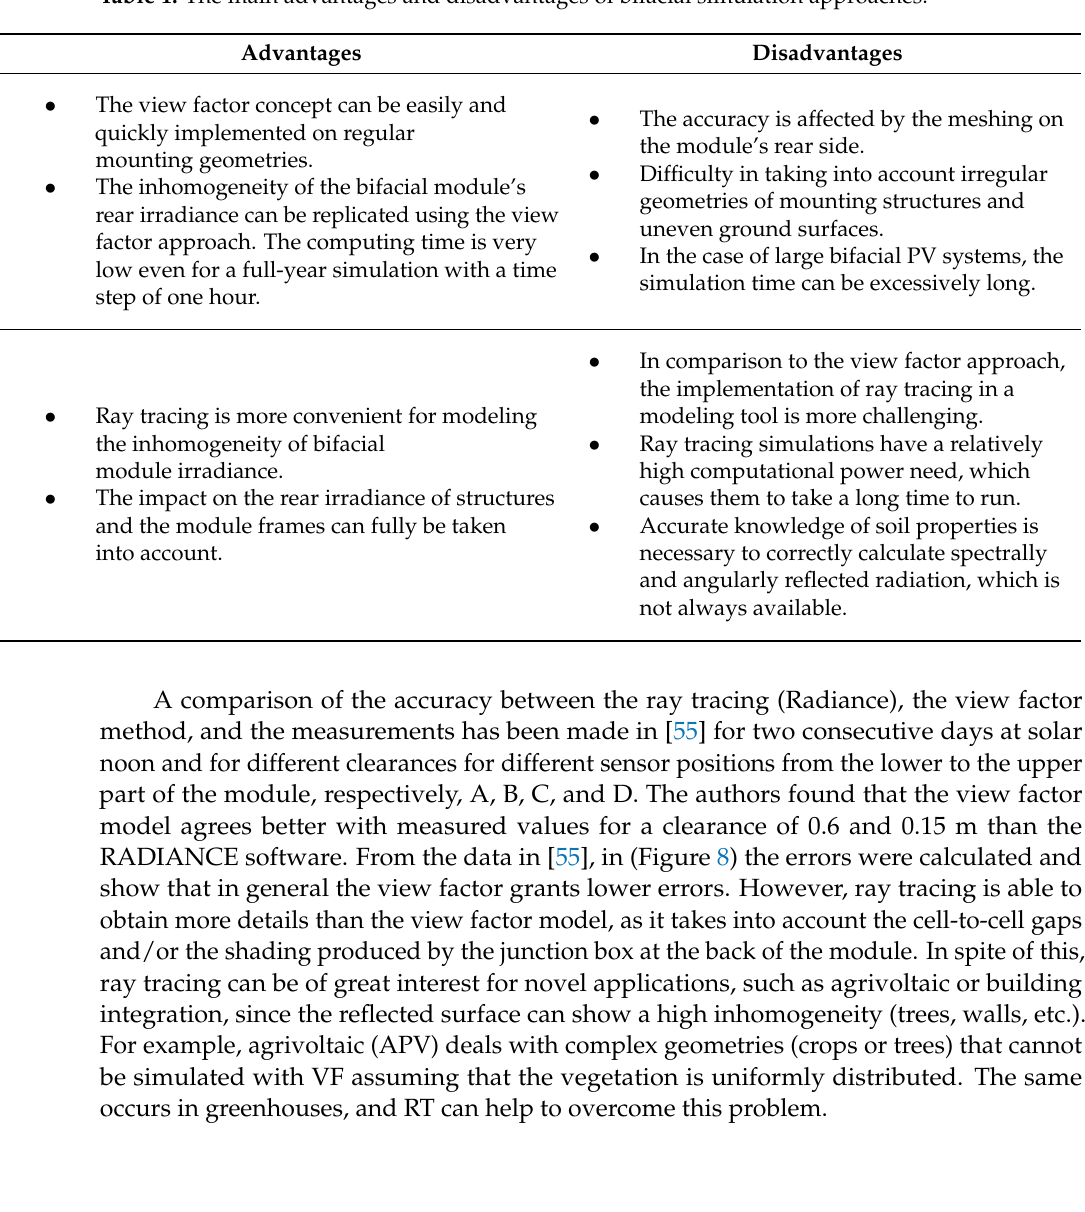
Table 1. The main advantages and disadvantages of bifacial simulation